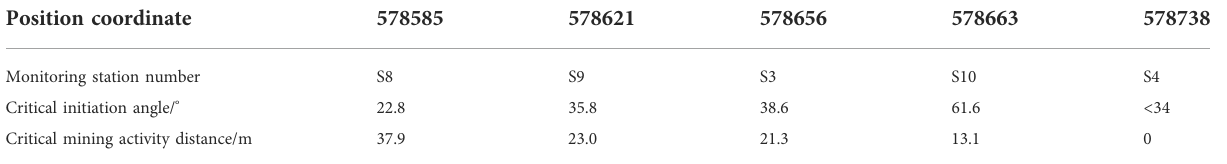
TABLE 3 Critical initiation angles and critical mining activity distances at different positions in the haulage